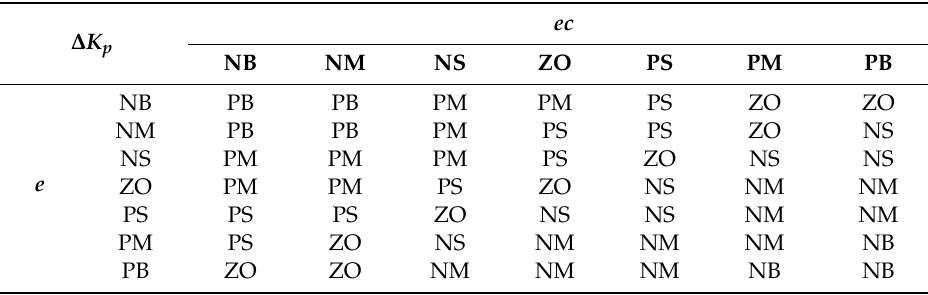
Table 2. ∆ Kp fuzzy control Table 2. Δ Kp fuzzy control rule.